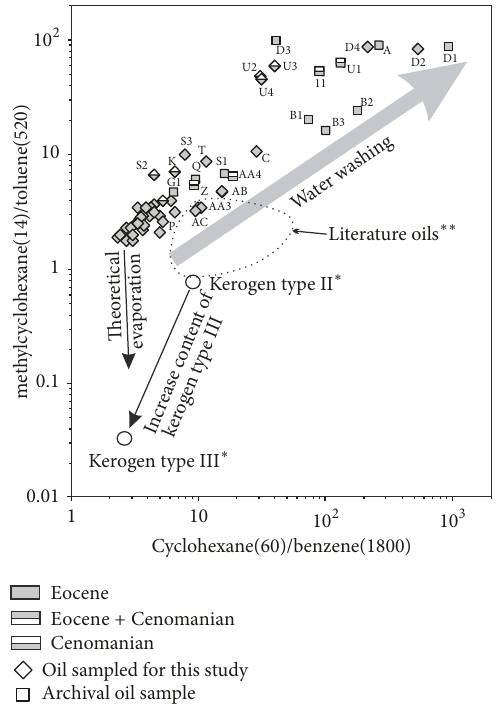
Figure 6: Cross-plot of the methylcyclohexane/toluene (Mch/T) ratio versus the cyclohexane/benzene (Ch/B) ratio. Ratios are calculated from chromatographic peak areas. Solubilities (mg/l at 20 ∘ C) of different compounds in water are given in brackets. Because aromatic compounds are more soluble in water, water washing results in an increase in Mch/T and Ch/B ratios. The theoretical evaporation trend, assuming simple mixtures of two compounds, is indicated (vapor pressure at 20 ∘ C for Mch: 48.3 hPa, Tol: 29.1 hPa, Ch: 104 hPa, B: 100hPa after [18]). ∗ Signature for kerogen type after Schaefer et al. [19]. Note that land plant-rich type III kerogen yields hydrocarbons with high contents of aromatic compounds resulting in very low Mch/T and Ch/B ratios. ∗∗ Dotted line delineates typical Mch/T and Ch/B values from unaltered oils in the Rocky Mountain area [20], Gulf of Mexico (Pleistocene), California (Miocene), Louisiana (Lower Cretaceous [21]), North Slope (Alaska [22]), Mexican Gulf Coast Basin [23], North Central Sinai [24], and SW Barents Sea